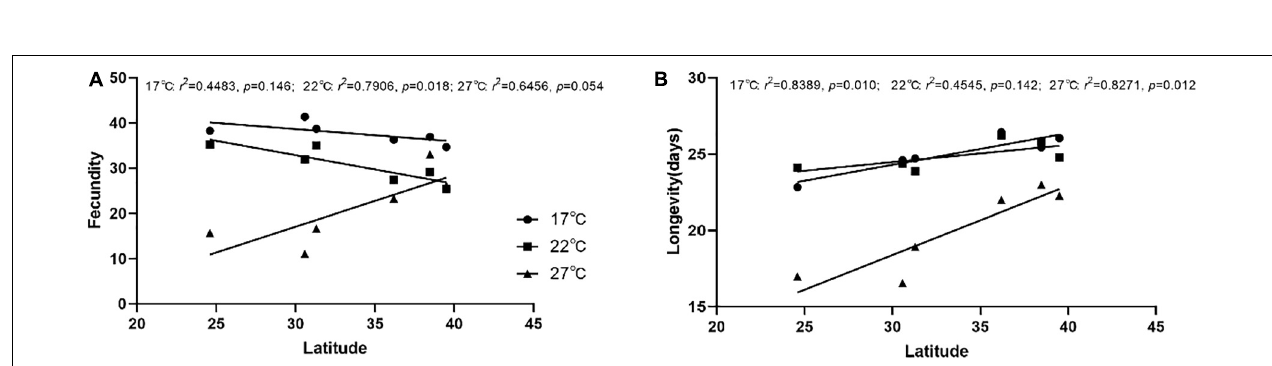
FIGURE 5 | Analysis of the linear correlations between the latitudes of the six locations and the fecundity of S. miscanthi . (A) Linear correlation between latitude and fecundity, (B) Linear correlation between latitude and Longevity.